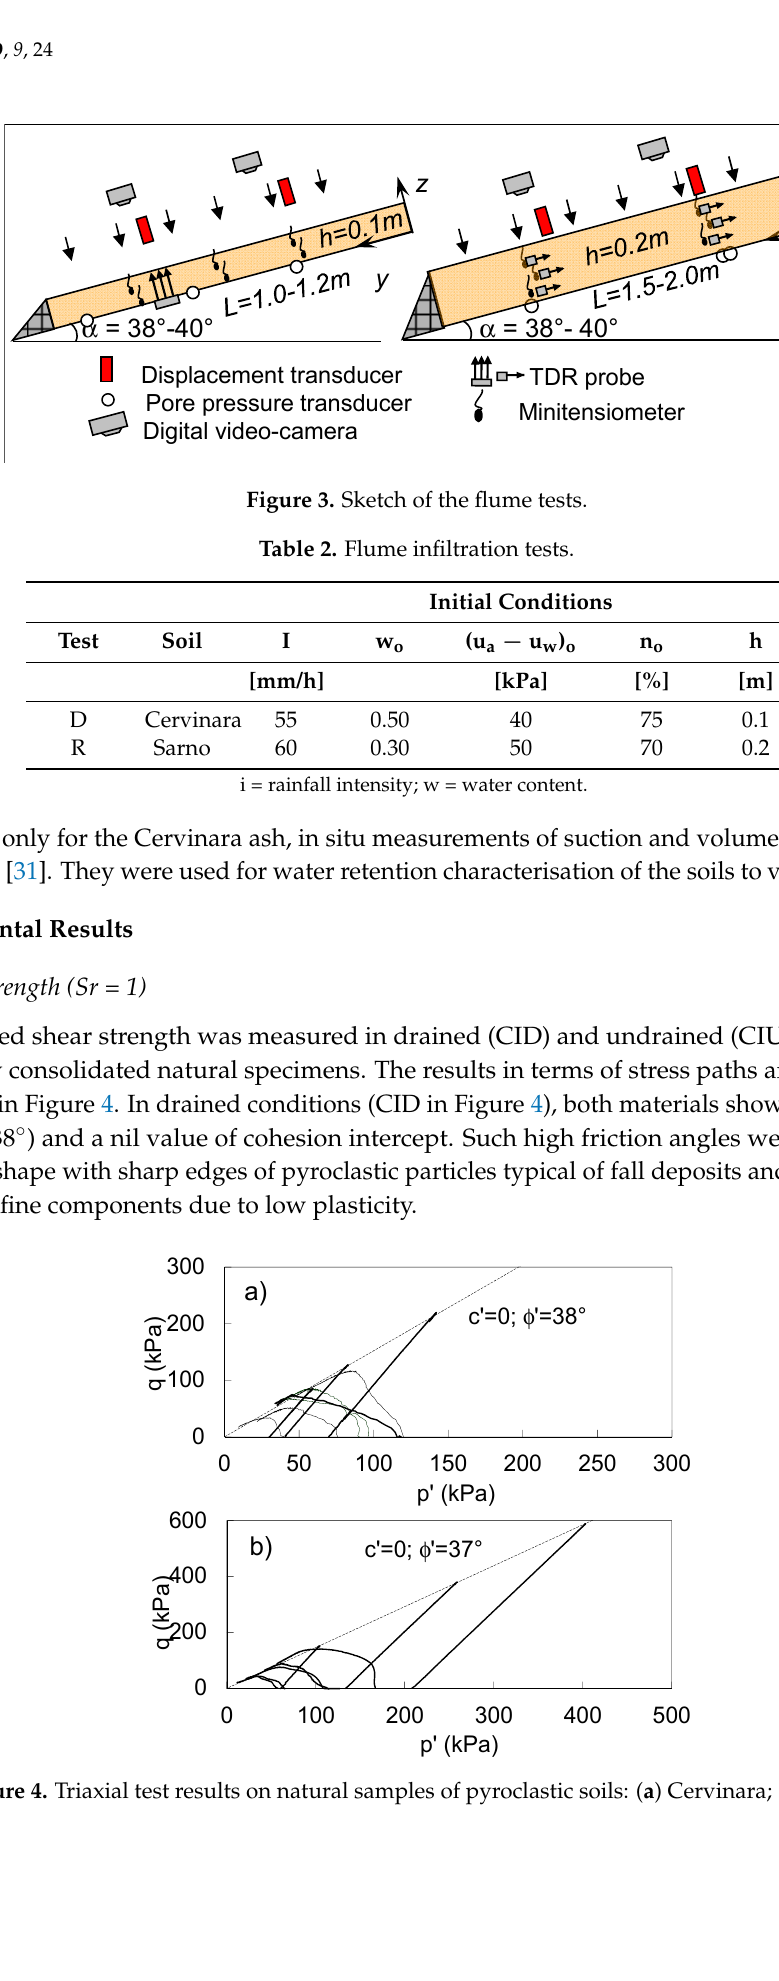
Figure 4. Triaxial test results on natural samples of pyroclastic soils: ( a ) Cervinara; ( b ) Sarno.